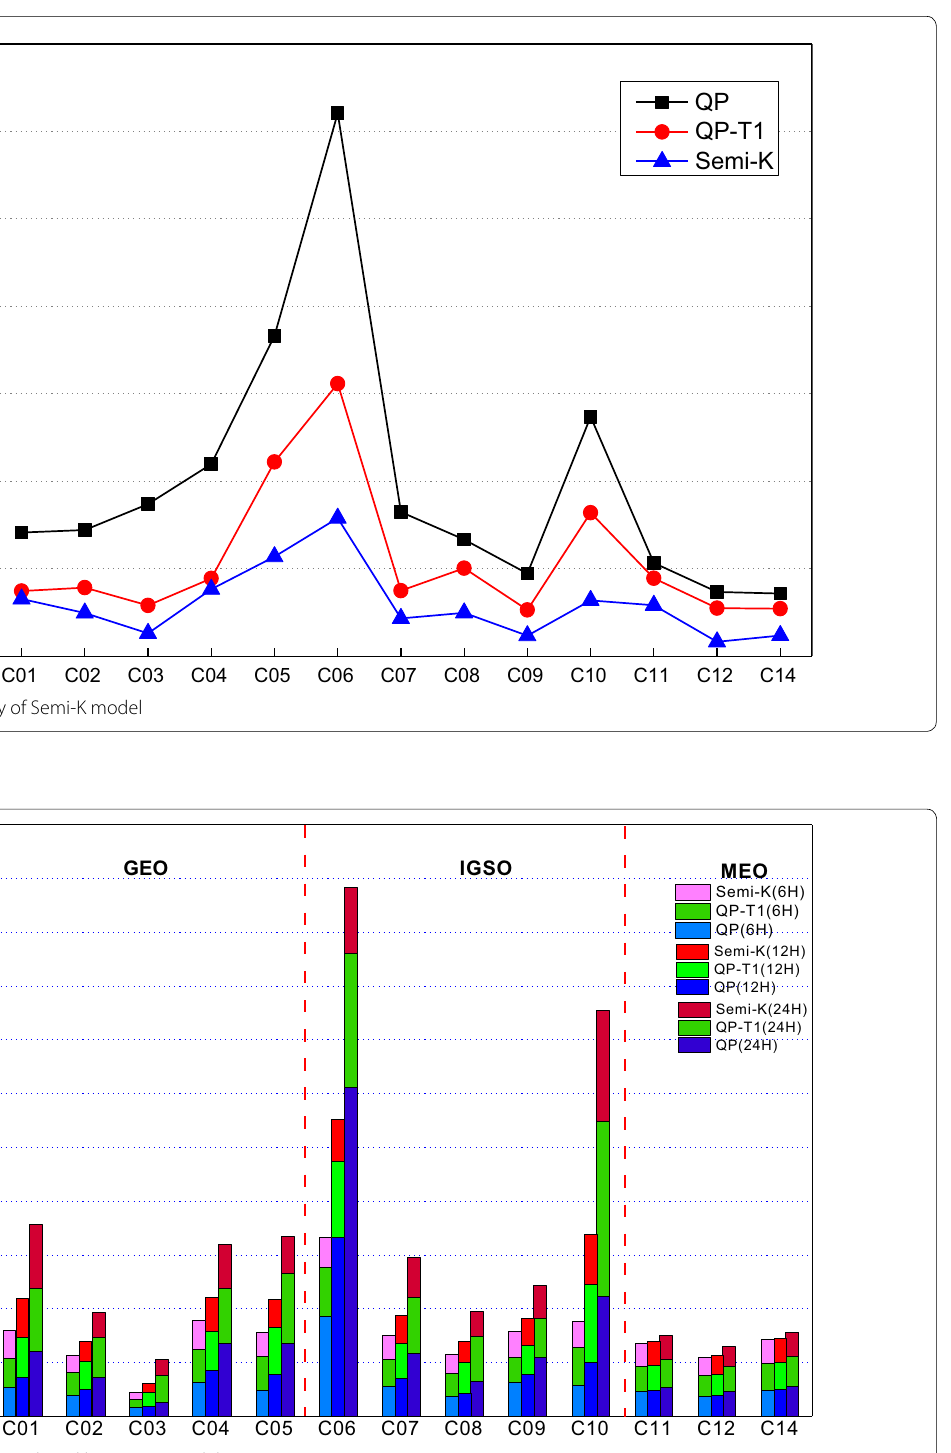
Fig. 8 Cylindrical stacking map predicted by Semi-K